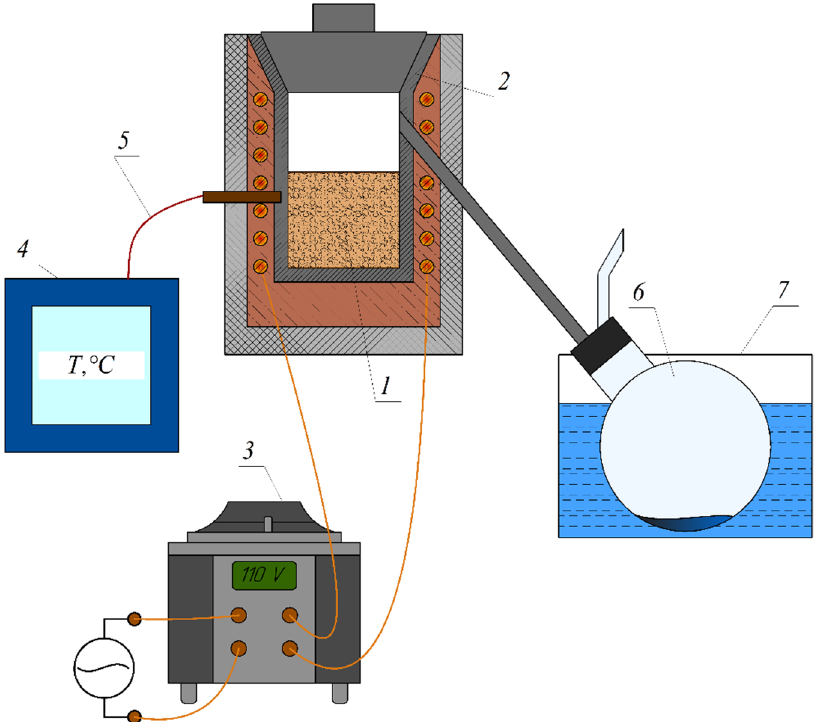
Figure 1. Laboratory installation for determining the yield of pyrolysis products: 1—Siberian pine nutshell, 2—reactor, 3—laboratory transformer, 4—high-precision multichannel temperature meter TM 5104 (Elemer, Russia), 5—K-type thermocouple, 6—receiver flask, 7—cooling water bath.